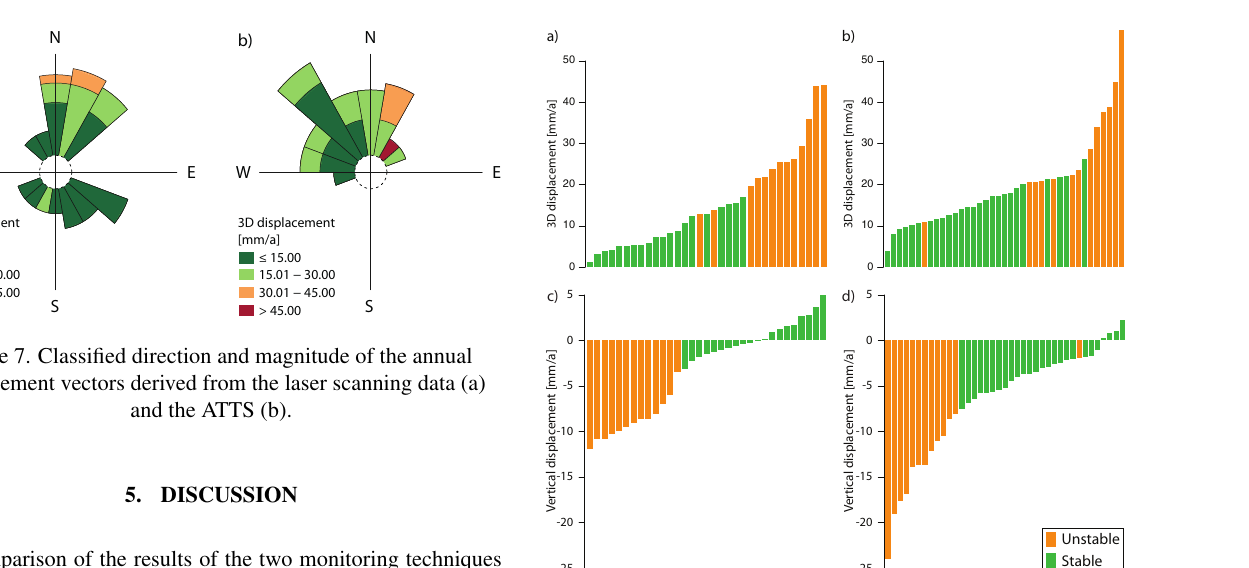
Figure 6. Annual horizontal and vertical displacement vectors derived from the laser scanning data (horizontal in red, vertical in orange) and the ATTS (horizontal in black, vertical in blue) for the study area (a) and a detail view of the active area (b). For visualization purposes the length of the vectors is scaled up by the factor 1000.